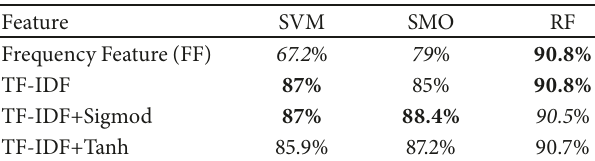
Table 8: Recognition F-Measures using three classifiers concerning dataset tulum2009.